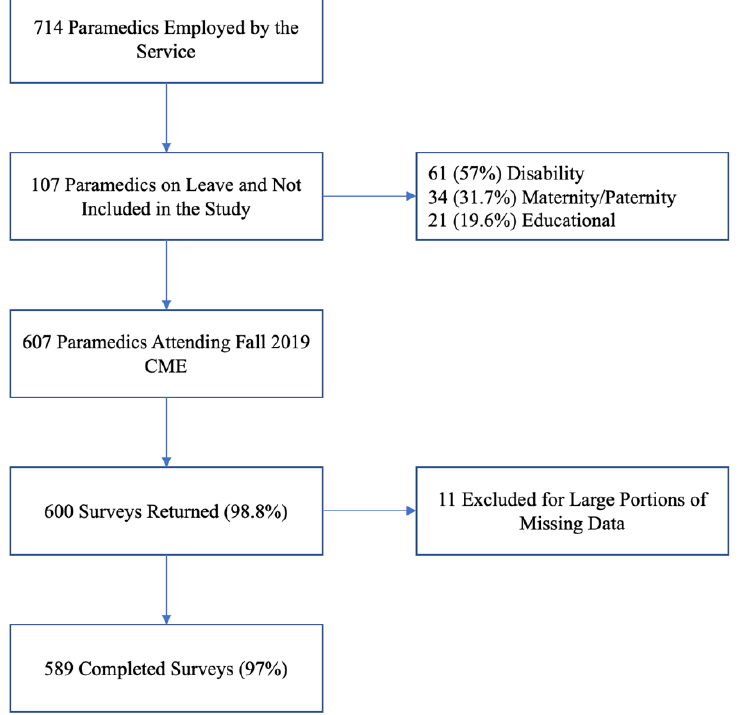
Figure 1. Participant flow diagram .